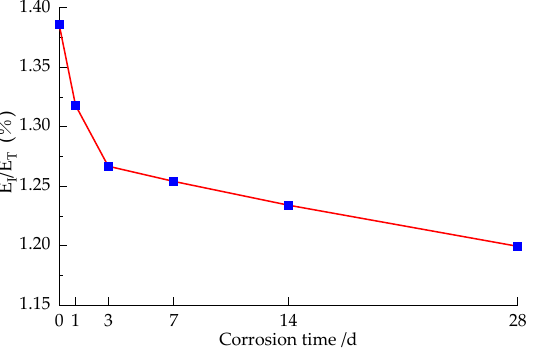
Figure 15. Transmitted energy percentage change curve with the corrosion time.